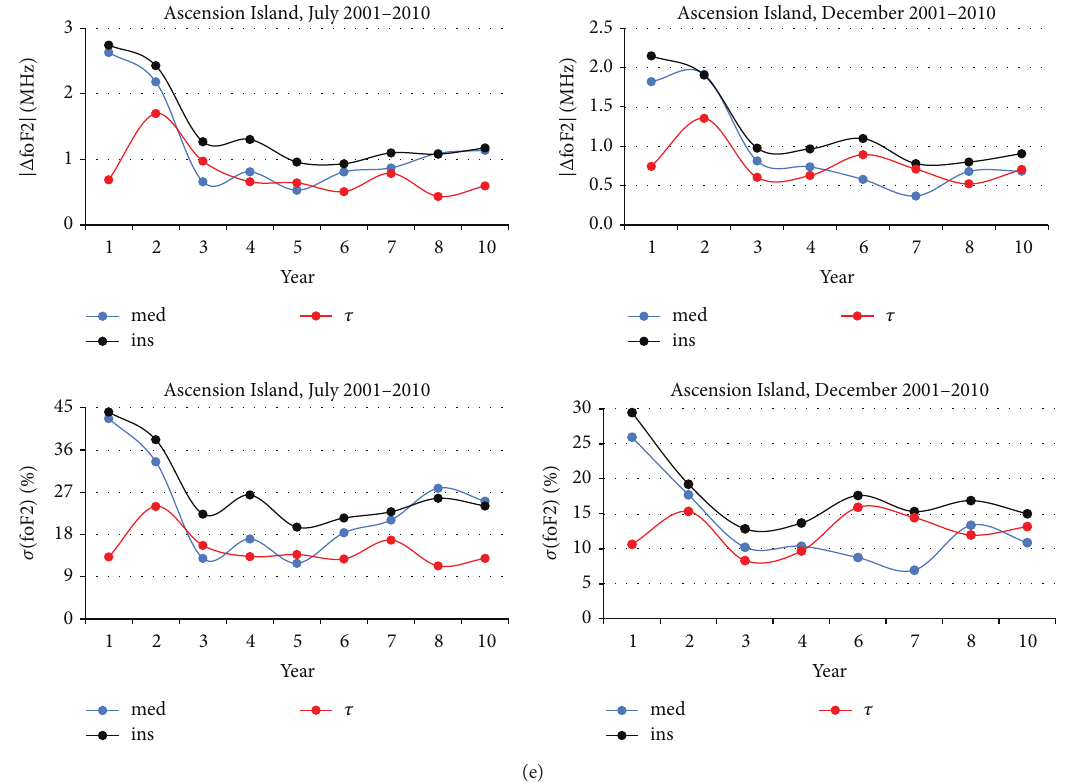
Figure 2: ( 1 ) Comparison of absolute and standard deviations of calculated foF2 from the experimental values for the middle-latitude station Juliusruh. (b) Comparison of absolute and standard deviations of calculated foF2 from the experimental values for the middle-latitude station Goosebay. (c) Comparison of absolute and standard deviations of calculated foF2 from the experimental values for the high-altitude station Thule. (d) Comparison of absolute and standard deviations of calculated foF2 from the experimental values for the low-latitude station Grahamstown. (e) Comparison of absolute and standard deviations of calculated foF2 from the experimental values for the equatorial station Ascension Island.